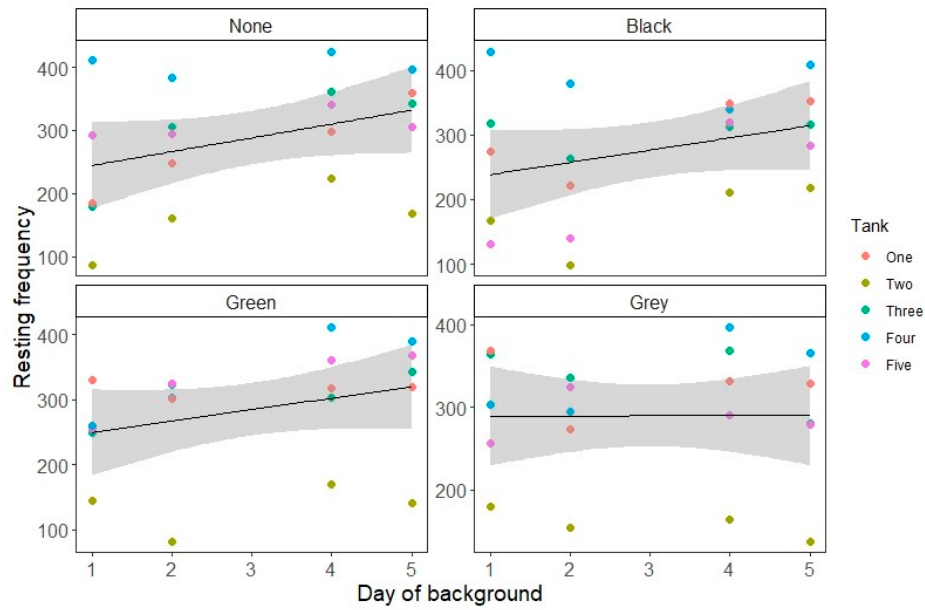
Figure 2. Resting count over time for each tank background, presented as swimming count for each tank on each day of the observation period. The grey area represents the standard error of the esti- mate.